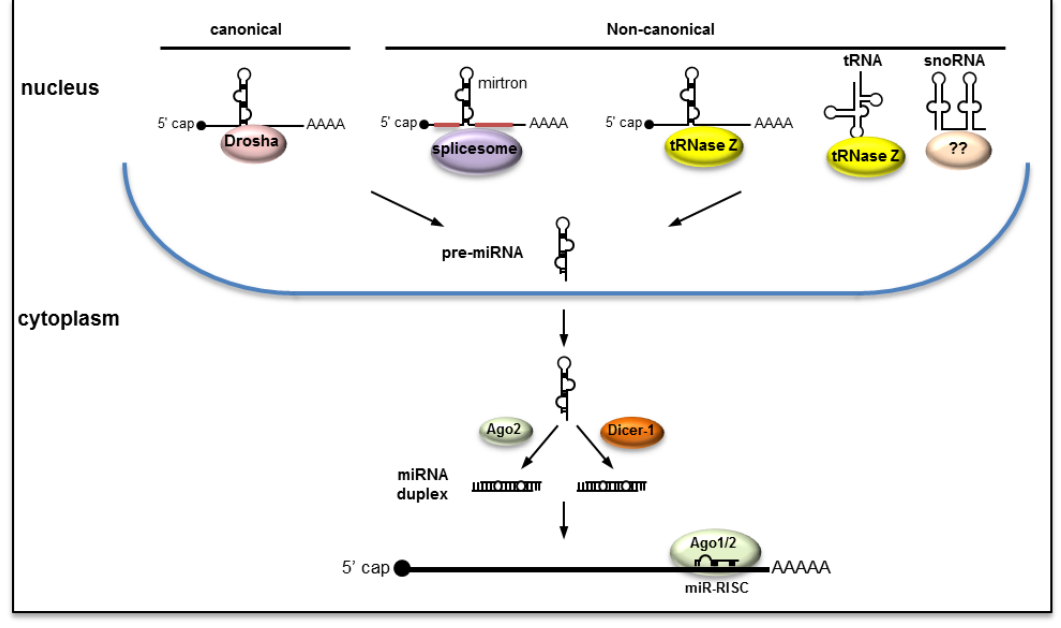
Figure 1. miRNAs are produced through canonical as well as non-canonical